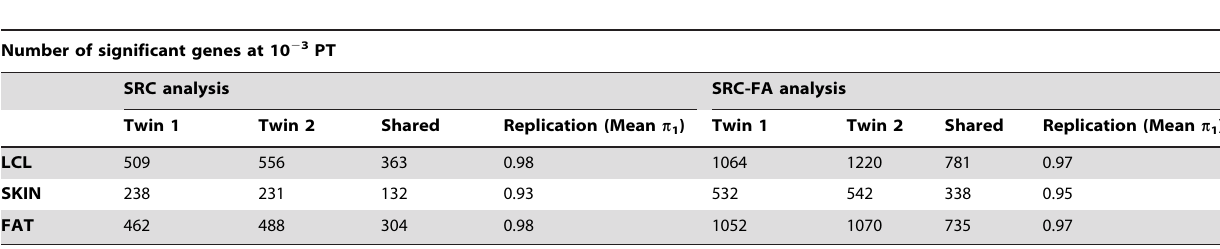
Table 1. Cis eQTL discoveries (number of genes) per tissue at 10 2 3